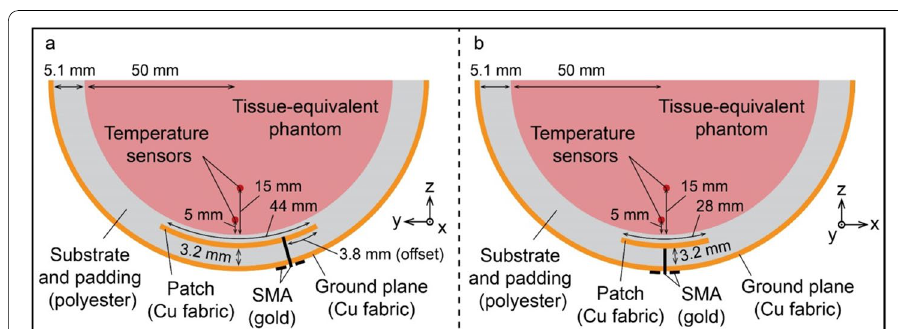
Fig. 1 Cross-sections of the textile patch antenna conforming to the hemispheric breast phantom; a yz-slice and b zx-slice (not to